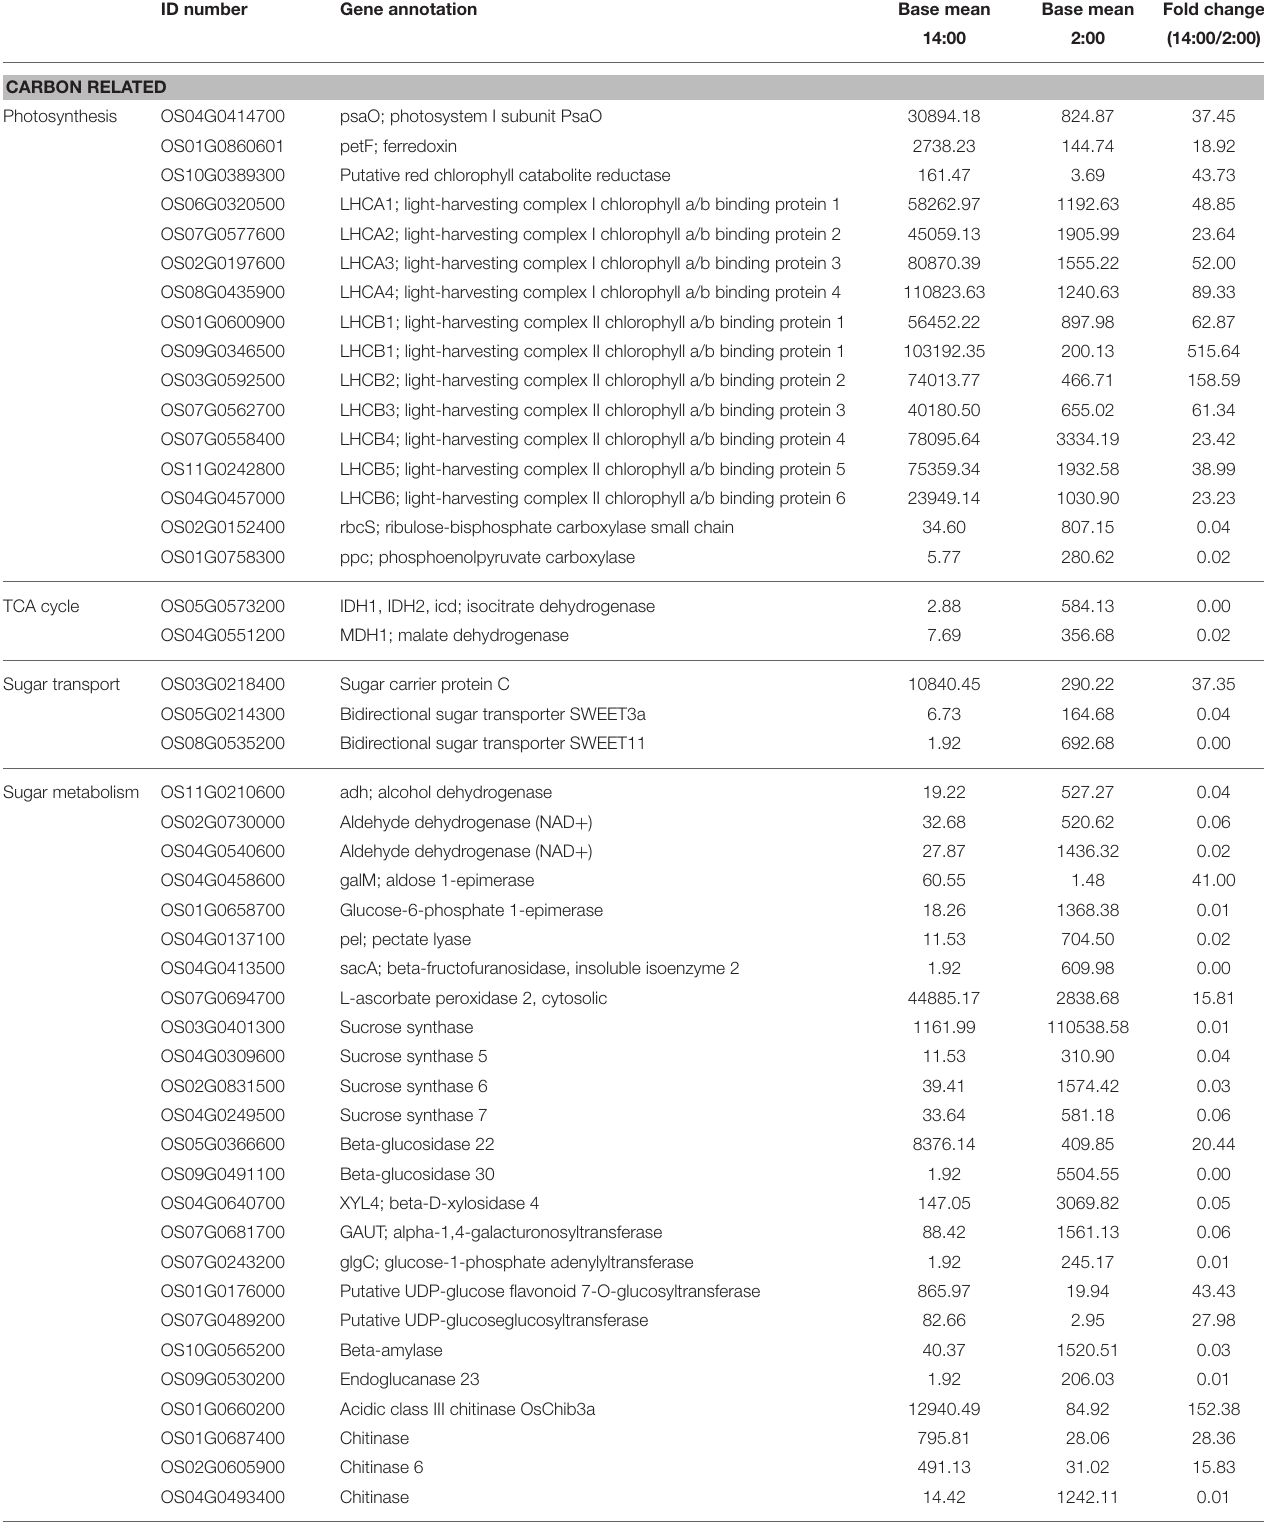
TABLE 3 | Differentially expressed genes involved in carbon and nitrogen metabolism at the time of 14:00 compared to